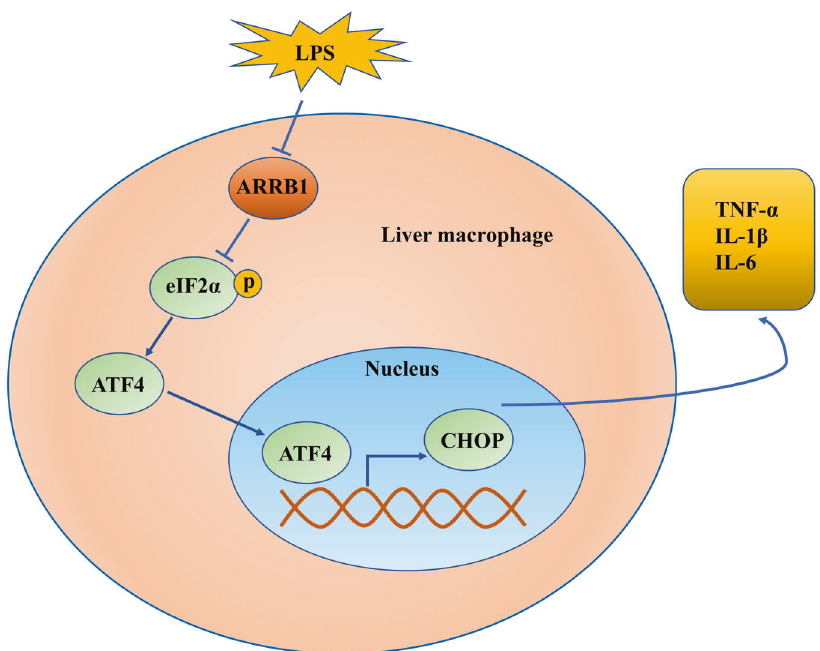
Fig. 7 Summary of the proposed regulatory mechanism of ARRB1 in this study. ARRB1 suppresses LPS-induced release of in fl ammatory cytokines in response to activated macrophages. ARRB1 regulates the ER stress signaling pathway by inhibiting the phosphorylation of eIF2 α and downstream ATF4 and CHOP expression in liver